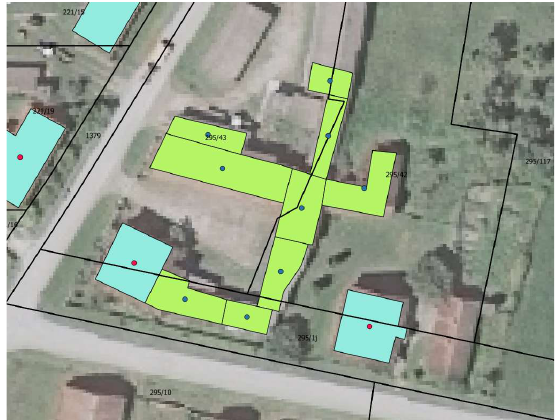
Figure 8. Example of spatial inconsistency of reference LM and cadastral data resulting in wrong or none owner assignment